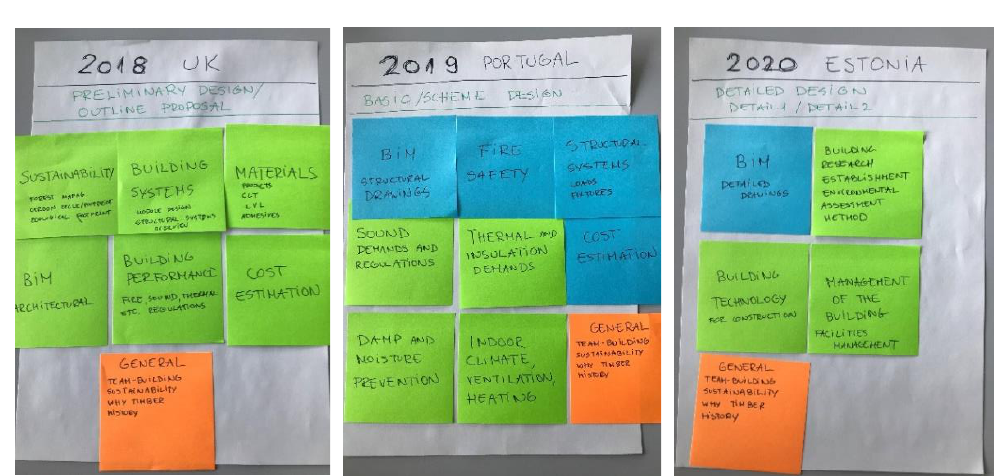
Fig. 1. Planning of workshops and lecture topics (picture by the